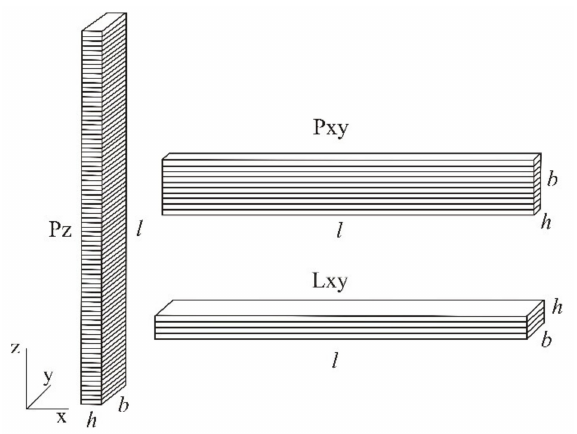
Figure 2. Layer orientation.